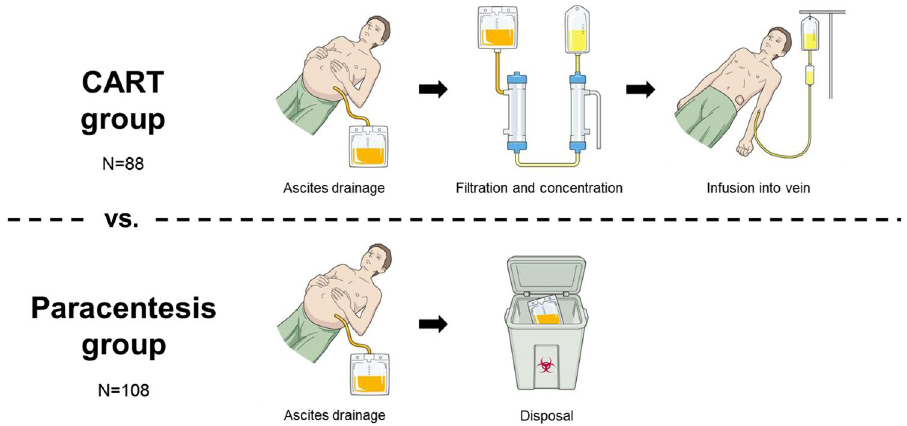
Figure 1. Conceptual diagram of this study (CART vs. paracentesis). CART group: after ascites drainage, cancer and other cells and bacteria in the ascitic fluid are eliminated with a filter membrane and excess water is removed with a concentrator membrane. The final product is infused back into the patient’s vein. Paracentesis group: after drainage, all ascites is discarded. The copyright holder, Yosuke Yamada, permits to publish these images under a CC BY open access